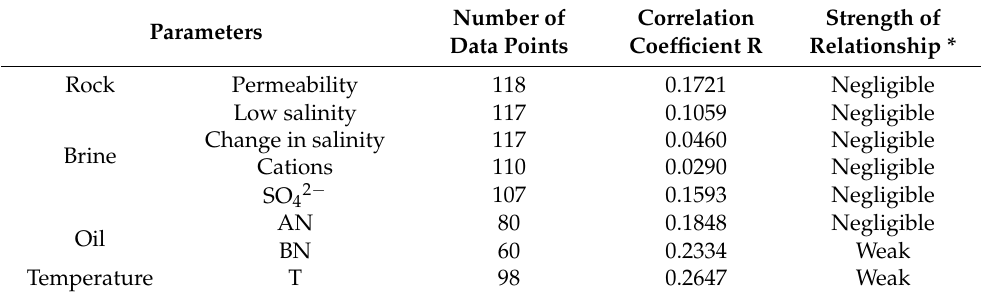
Table 5. Single-variable linear regression